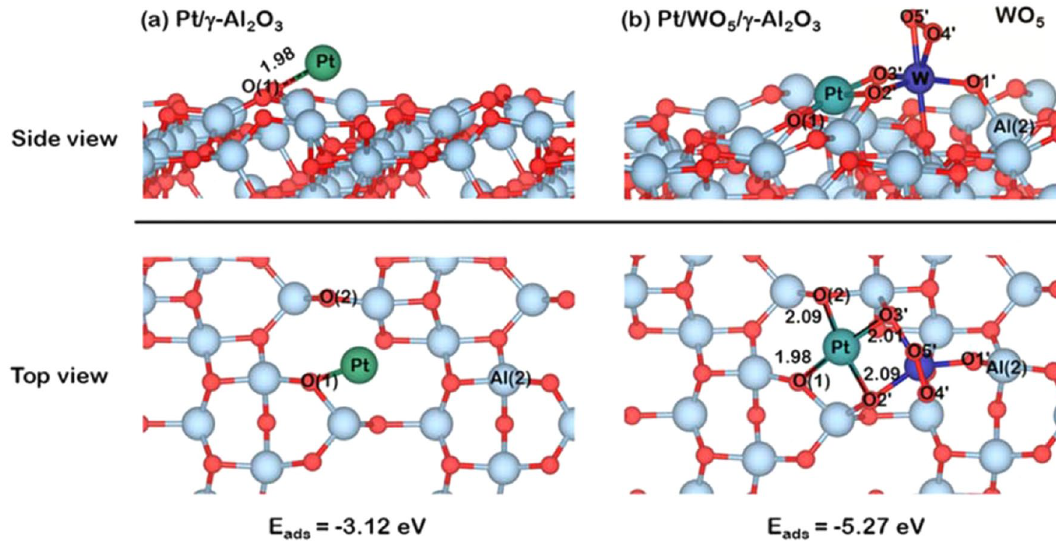
Figure 5. Top and side views of the most stable adsorption structures of Pt atom on ( a ) γ-Al 2 O 3 and ( b ) WO 5 /γ-Al 2 O 3 surfaces. Note that the atomic radius of each atom is modeled to its isolated atomic radius.